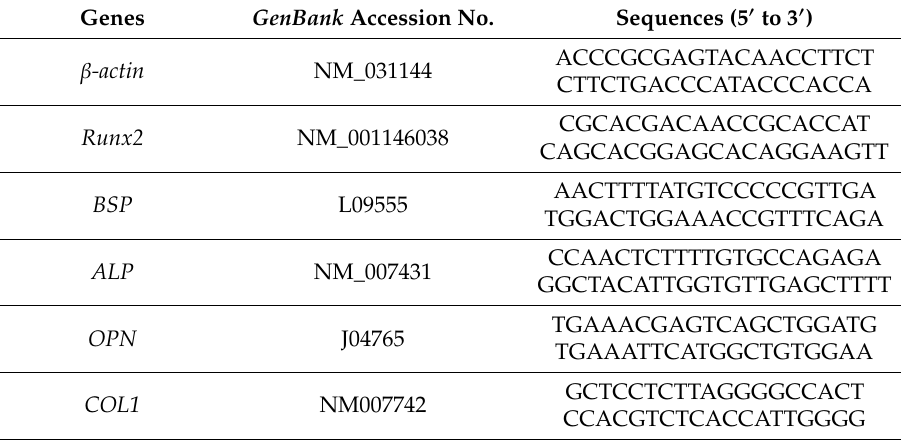
Table 1. Specified gene primer sequences used in the qRT-PCR analysis.